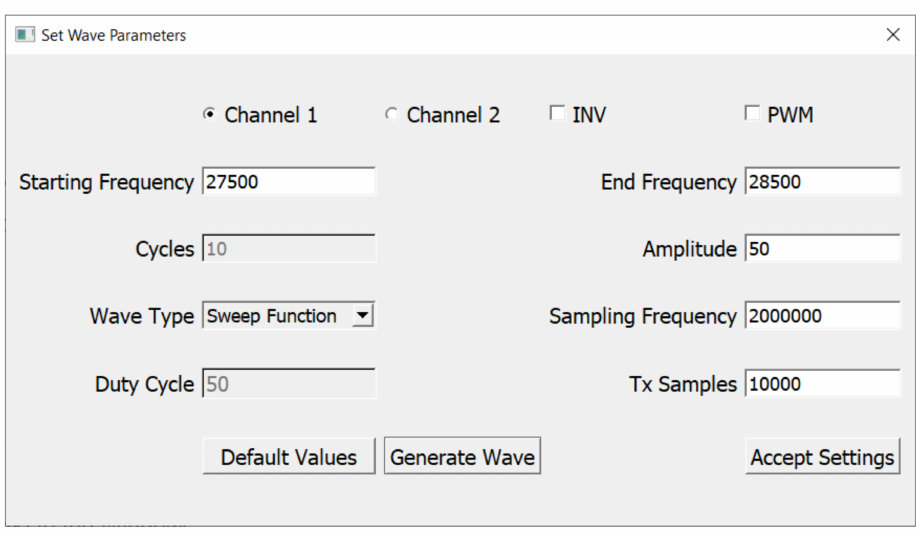
Figure 10. kHz sweep centered at 28 kHz for driving ultrasonic